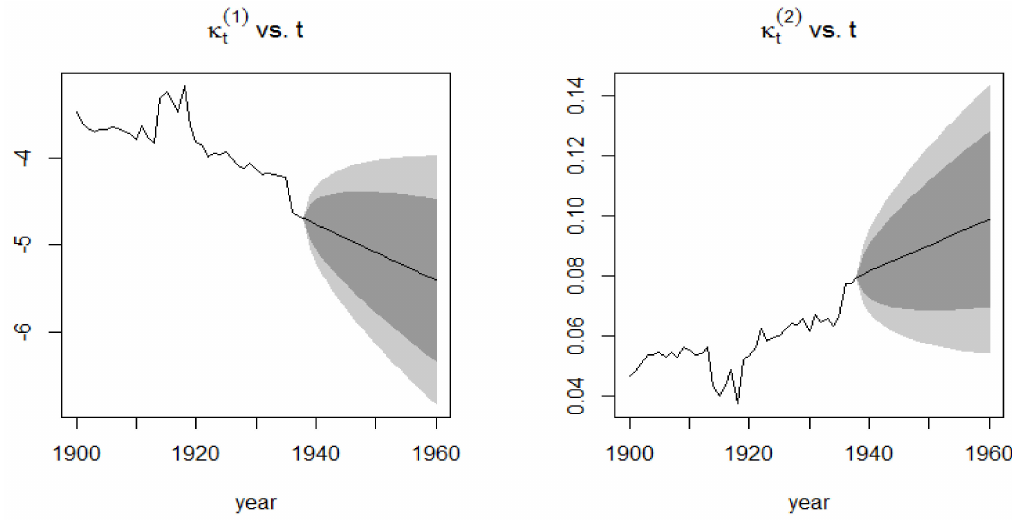
Figure 10. Forecasts of the two time-dependent parameters of the CBD model for the 1939–1960 period.